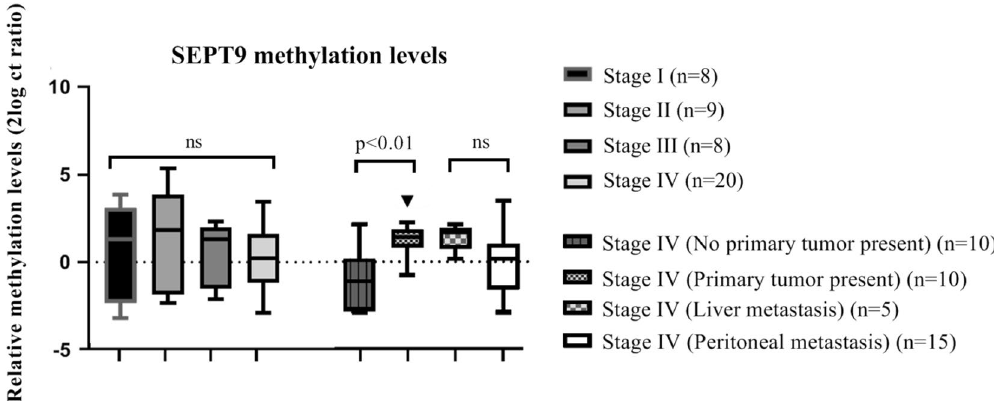
Figure 2. SEPT9 methylation levels in urine supernatant per CRC stage. Samples of patient with stage IV CRC have been further stratified in patients with and without the primary tumor still being present. Furthermore, methylation levels in patients with solely intraperitoneal metastases (n = 15) and patients diagnosed with stage IV due to liver metastases (n = 5) are shown. Data are shown as the median with interquartile range of 2log converted Ct ratios.